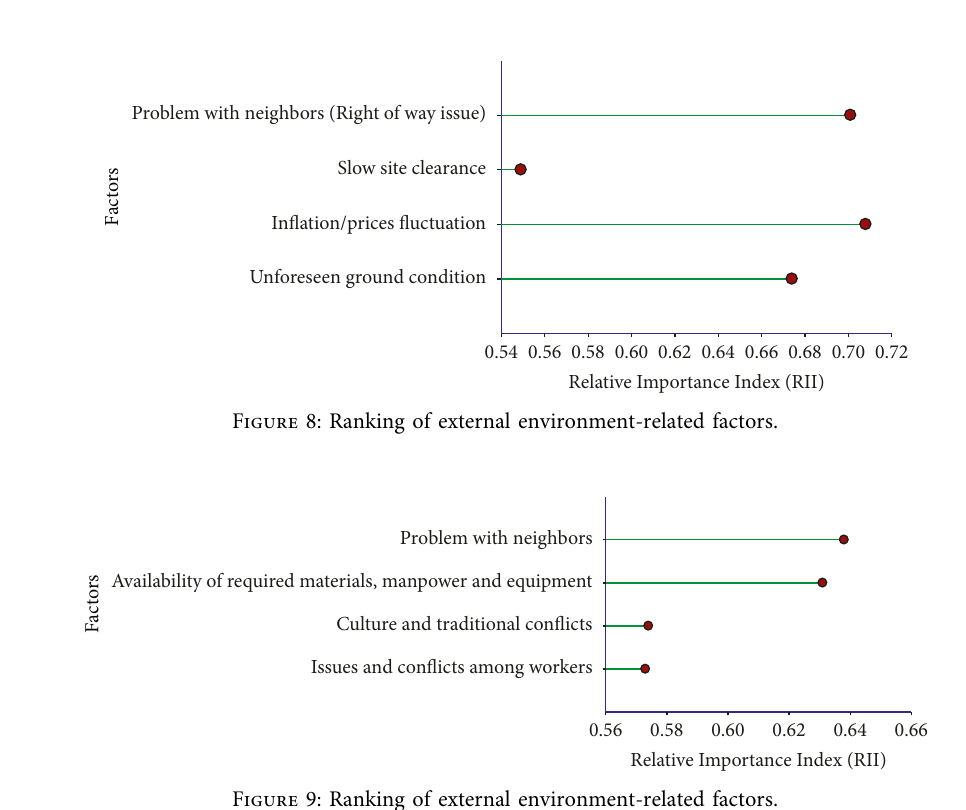
Figure 7: Ranking of financial-related factors.